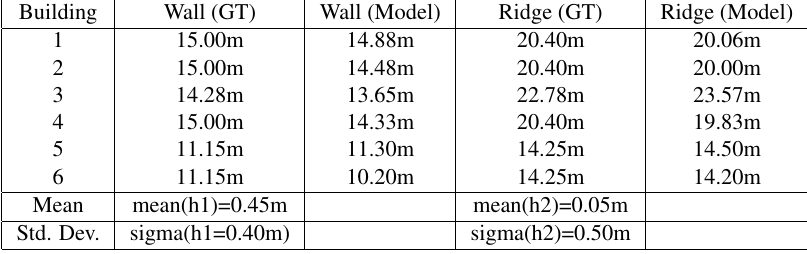
Table 1: Ground Truth (GT) vs. estimated values from 3D model